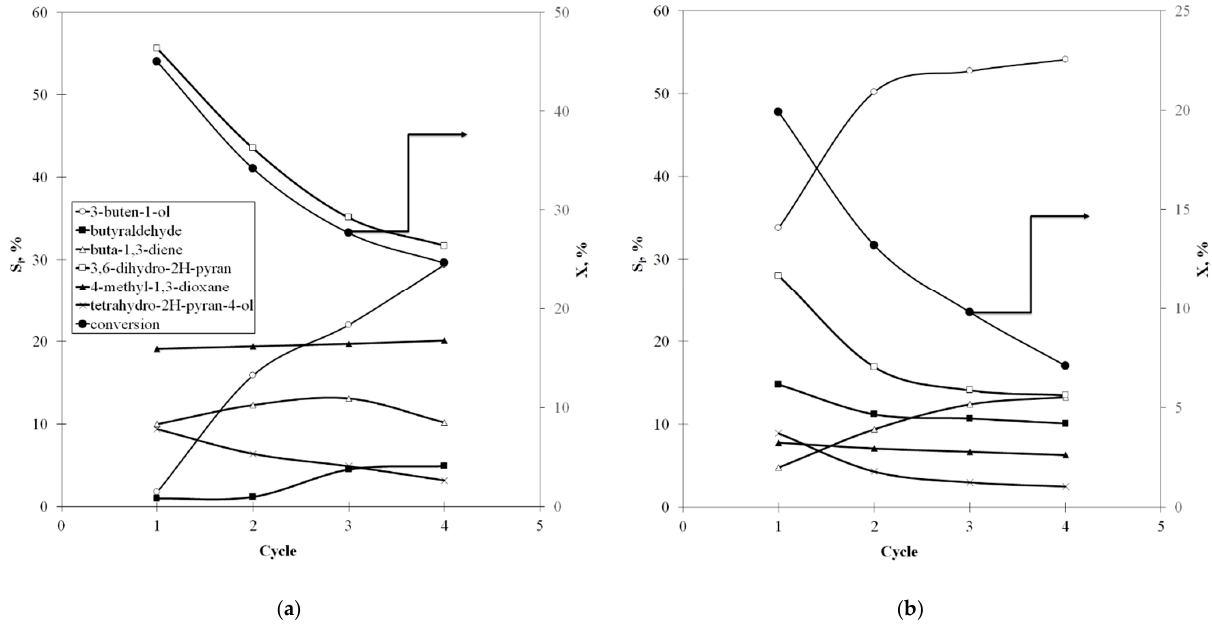
Figure 2. Formaldehyde conversion and product selectivity during stability test over H-BEA ( a ) and H-MFI ( b ).